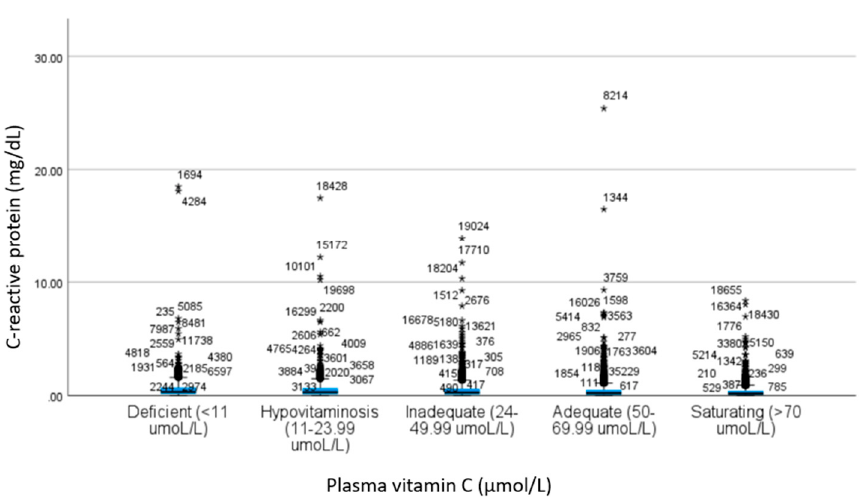
Figure 1. Participant CRP mean levels in plasma vitamin C categories. * denotes participant outlier. Mean RDW values for all insufficient plasma vitamin C categories (deficiency, hypovitaminosis, and inadequate) were significantly higher than the means in the sufficient plasma vitamin C categories (adequate and saturating). There were no significant group differences of RDW means between the insufficient categories of deficiency, hypovitaminosis, and inadequate or between the sufficient categories of adequate and saturating. Mean ranges of RDW identified between the insufficient categories of vitamin C were 12.8% (95% CI: 12.7–12.8) to 12.8% (95% CI: 12.8–12.9), while the ranges identified within the